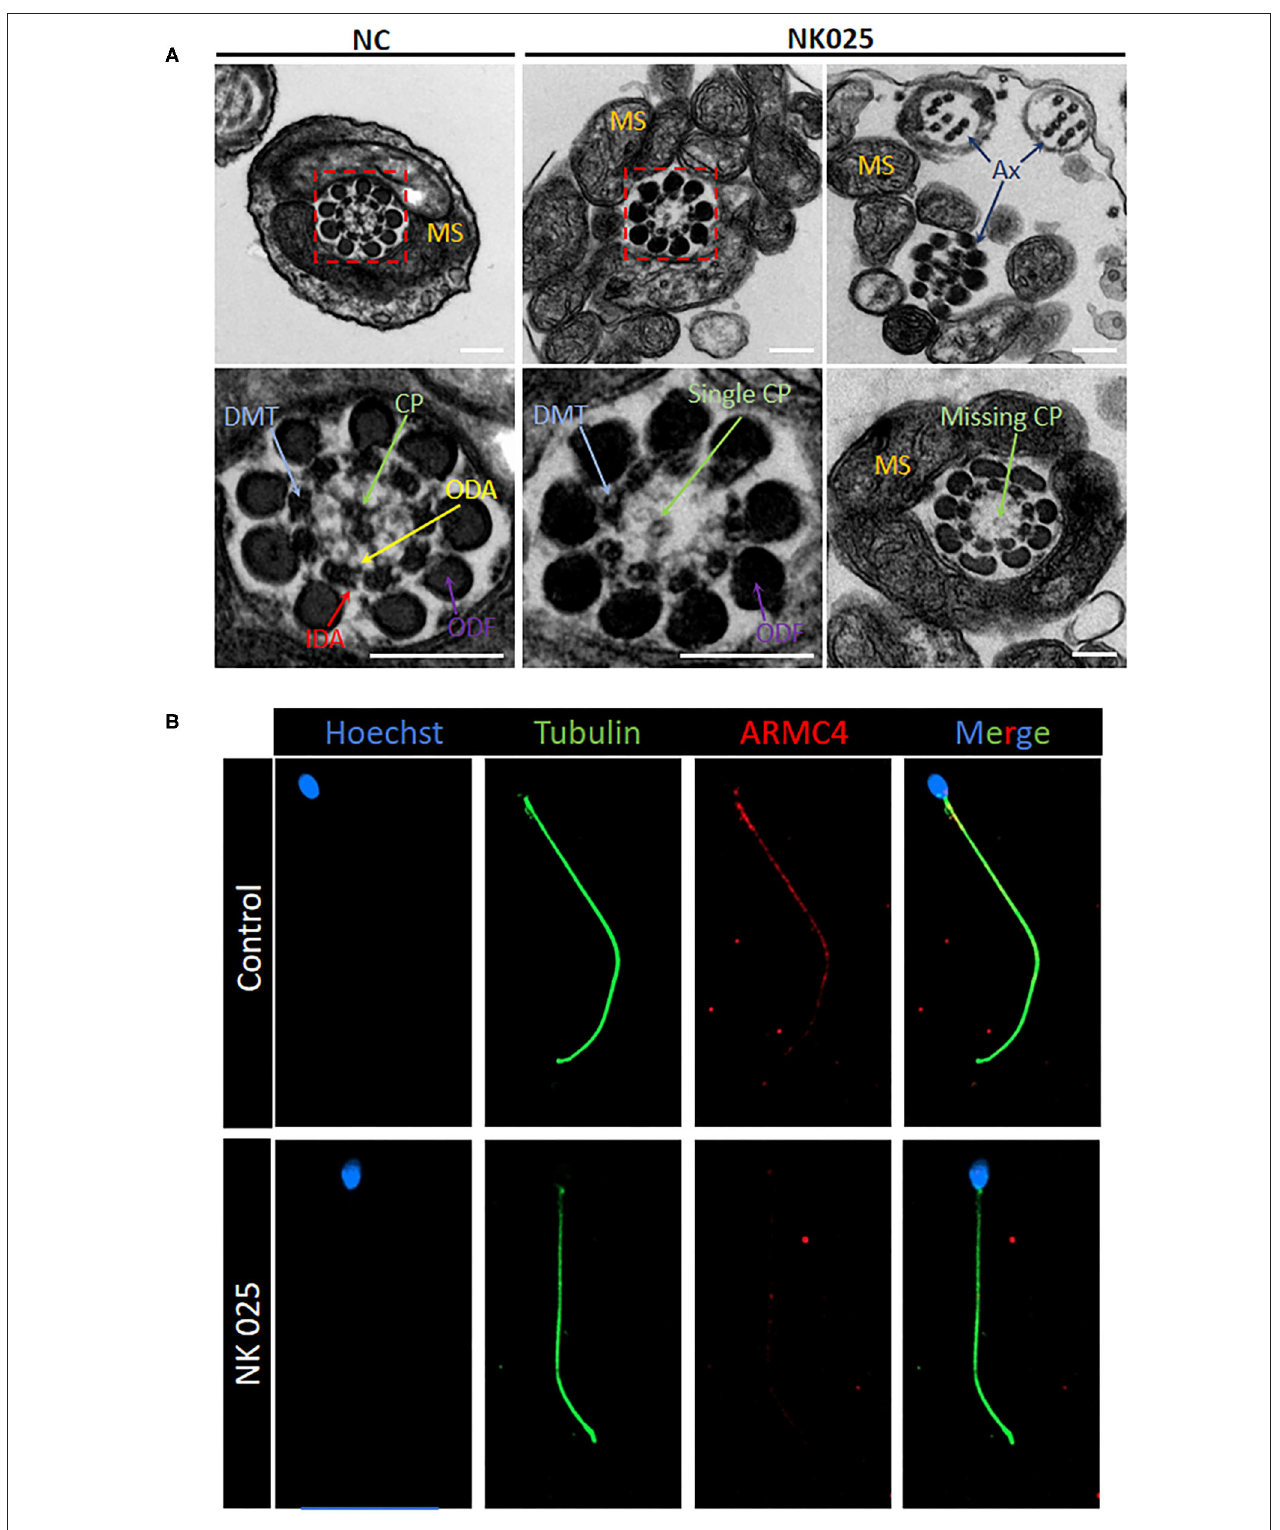
FIGURE 2 | The ARMC4 -mutated man exhibits lower ARMC4 protein expression and ultrastructural defects in axonemal structure. (A) Cross-sections of sperm flagella from the control man and the ARMC4 -mutated men. Compared with those in normal sperm flagella, the axoneme of ARMC4 -mutated men exhibited